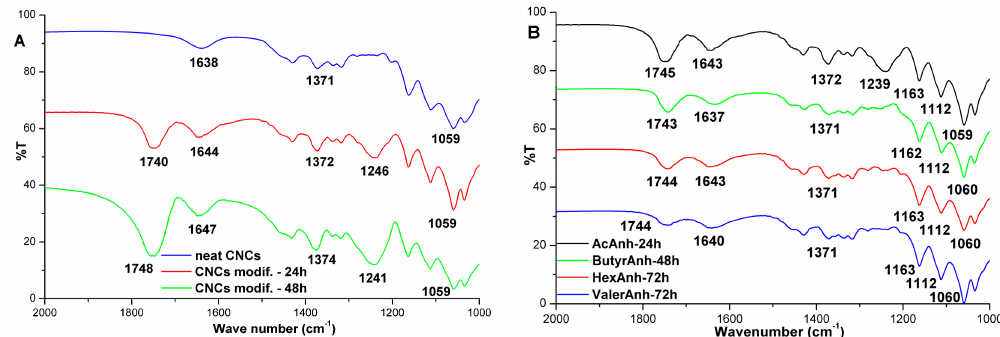
Figure 3. ( A ) FTIR spectra of CNCs modified with acetic anhydride (AcAnh) at room temperature and different reaction times; ( B ) FTIR spectra of CNCs modified with anhydrides of various alkyl chain lengths.